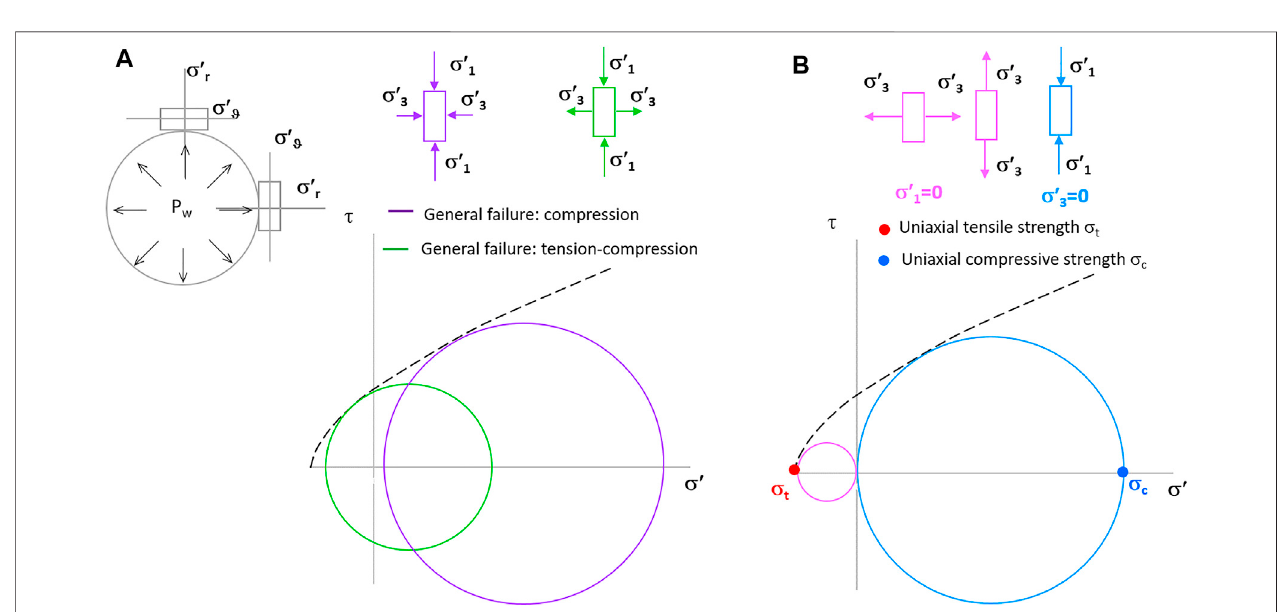
FIGURE 4 | Stress states at failure. (A) General case with positive and negative principal stresses (green circle) and positive principal stresses (violet circle). (B) Uniaxial tension (pink circle); uniaxial compression (turquoise circle).